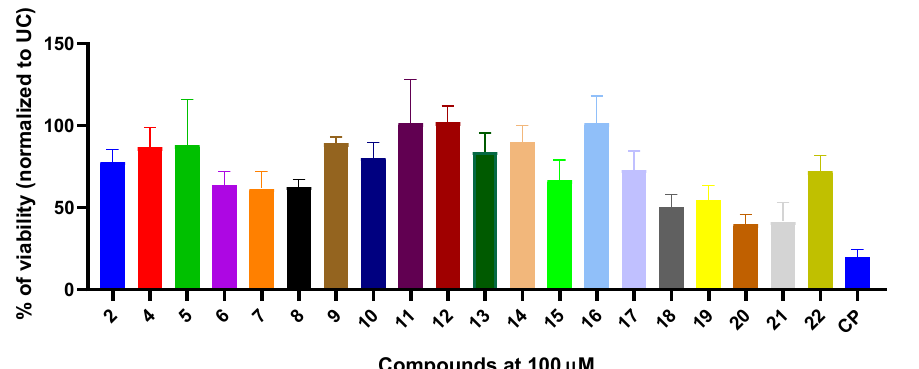
Figure 2. The anticancer activity of 5-oxopyrrolidine derivatives 2 and 4 – 22 on A549 human lung adenocarcinoma cells. The cells were exposed to 100 µM of each compound or cisplatin (CP) for 24 h and post-treatment viability was calculated using untreated control as a normalization marker. Data are shown as mean ∓ SD from 3 experimental replicas. Hydrazones 12 and 13 showed weak to no anticancer activity on A549 cells as well as weak cytotoxic activity on HSAEC1-KT cells (Figures 3).